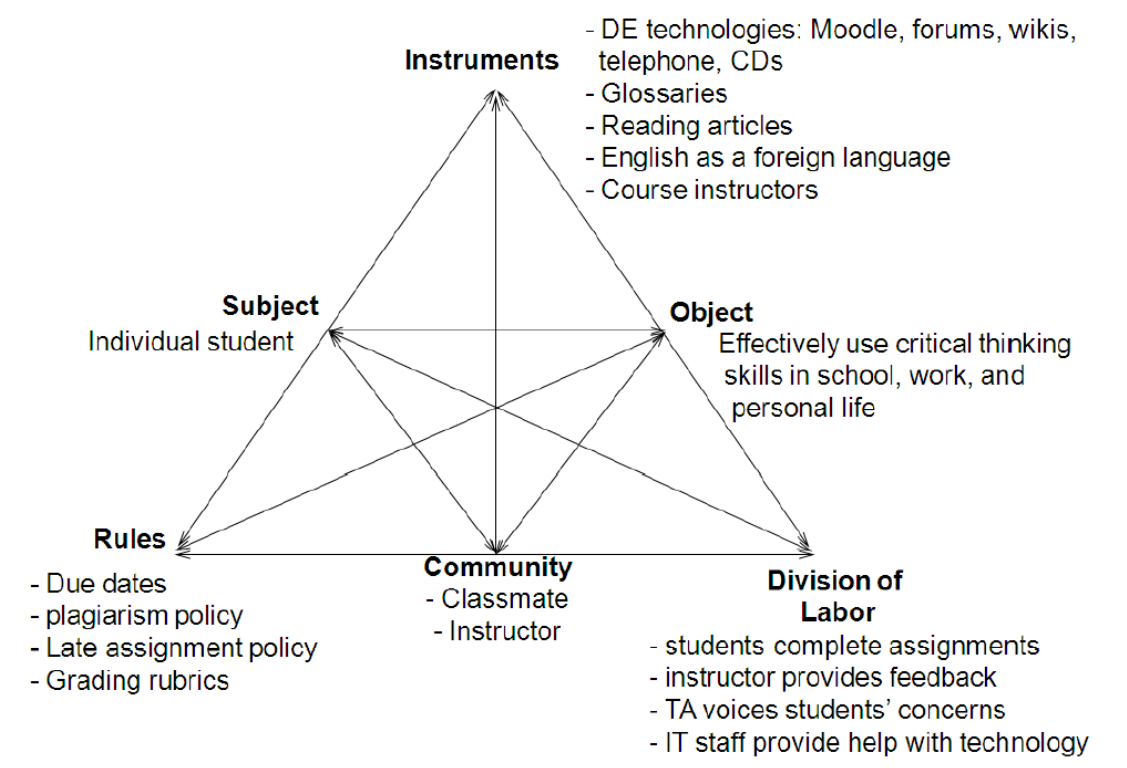
Figure 4 . A generic course taking activity